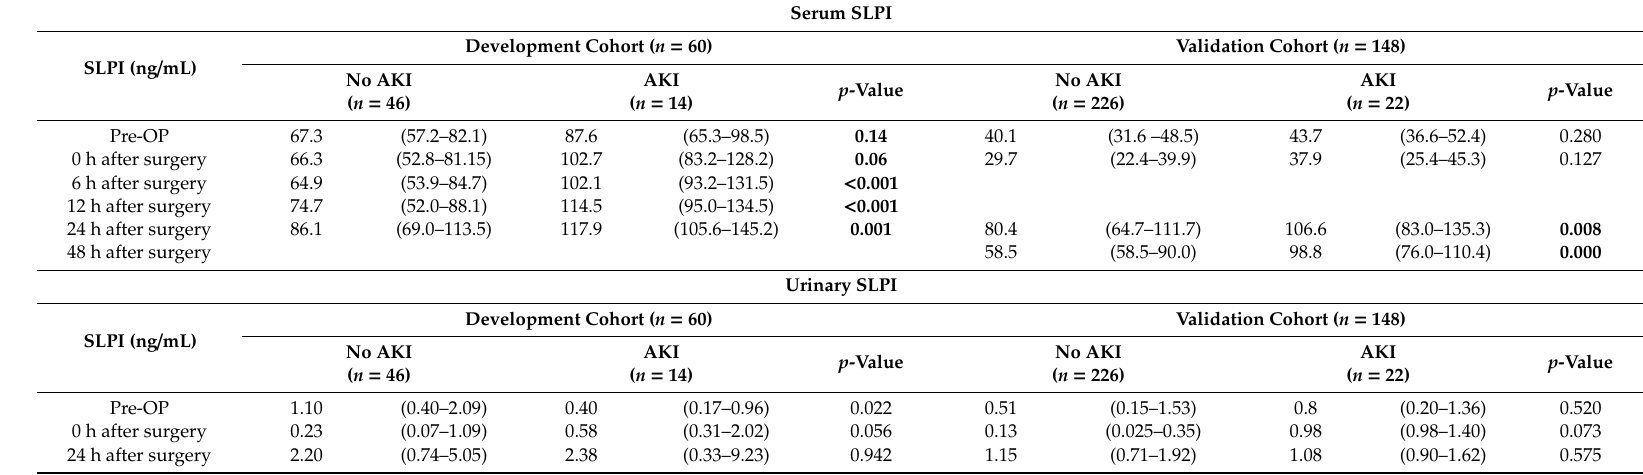
Table 3. SLPI measured at di ff erent time points. Serum and urinary SLPI concentrations quantified by ELISA and compared between patients with and without AKI. Bold fonts indicate p -values <